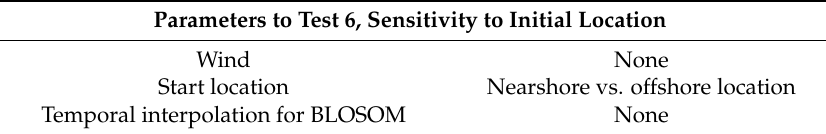
Table 9. Parameters to test 6, sensitivity to initial location.